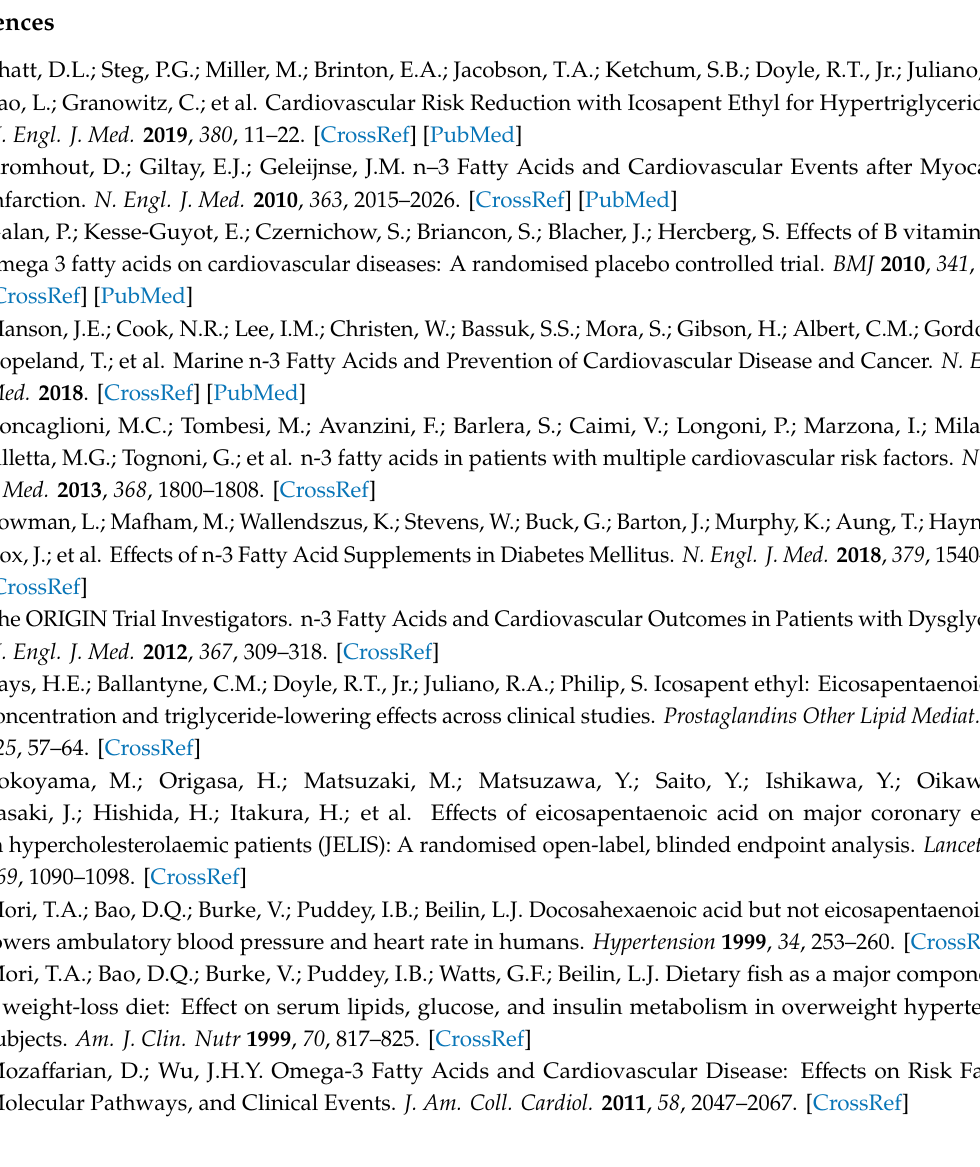
Supplementary Materials: The following are available online at http: // www.mdpi.com / 2072-6643 / 11 / 11 / 2599 / s1: Figure S1: E ff ect of low-dose marine omega-3 fatty acids on atherosclerosis; Table S1: Search strategy and number of articles retrieved in PubMed; Table S2: Search strategy and number of articles retrieved in Embase; Table S3: Characteristics of the trials with low-dose OM3; Table S4: Primary outcome of atherosclerosis and the result of each trial with low-dose OM3; Table S5: Risk of bias for trails with low-dose